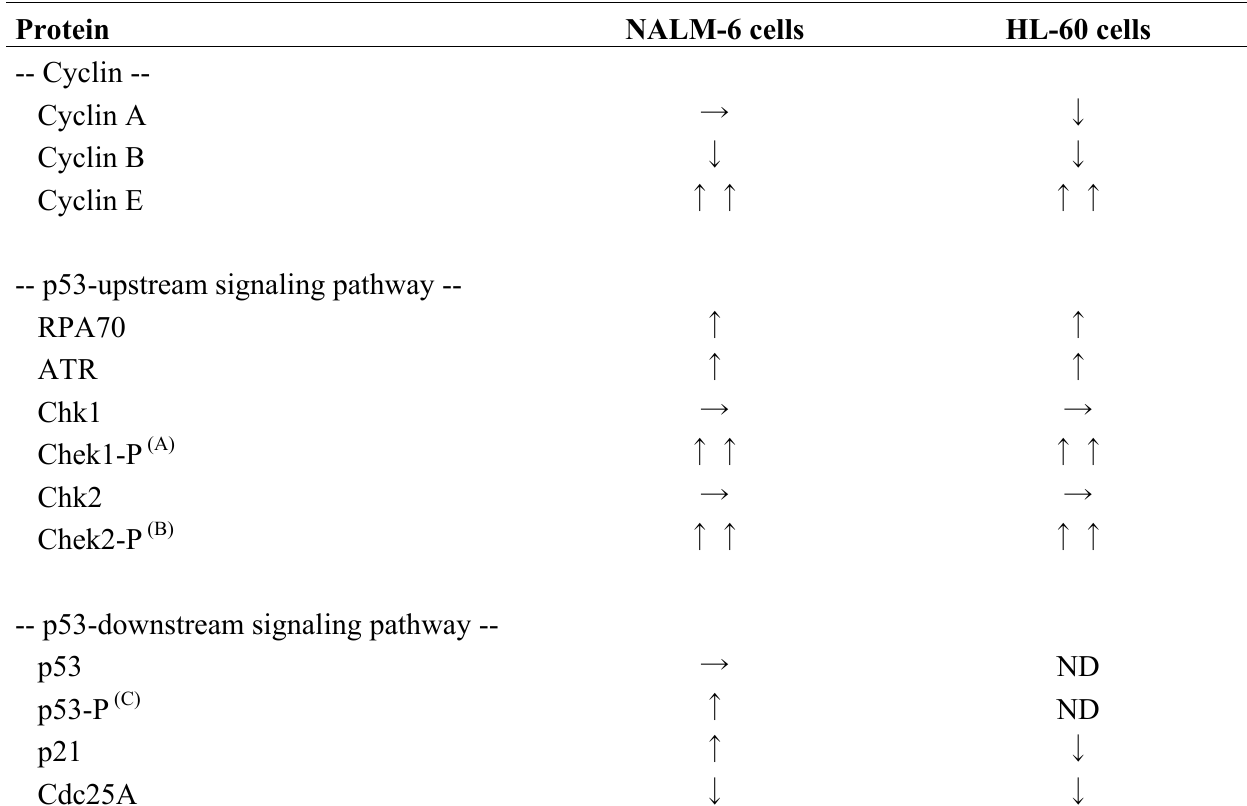
Table 2. Protein expressions of the extract of human cancer cells by cEPA influences using Western